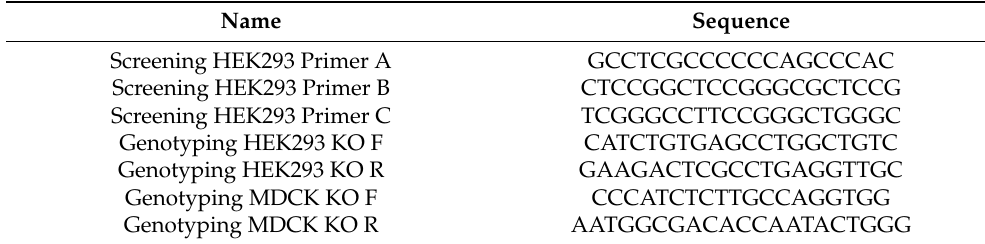
Table 1. List of the primers used for the screening and genotyping PCR of the SZT2 KO cell lines. The primer names refer to the schematic representation of the screening PCR shown in Figure S4A. Name